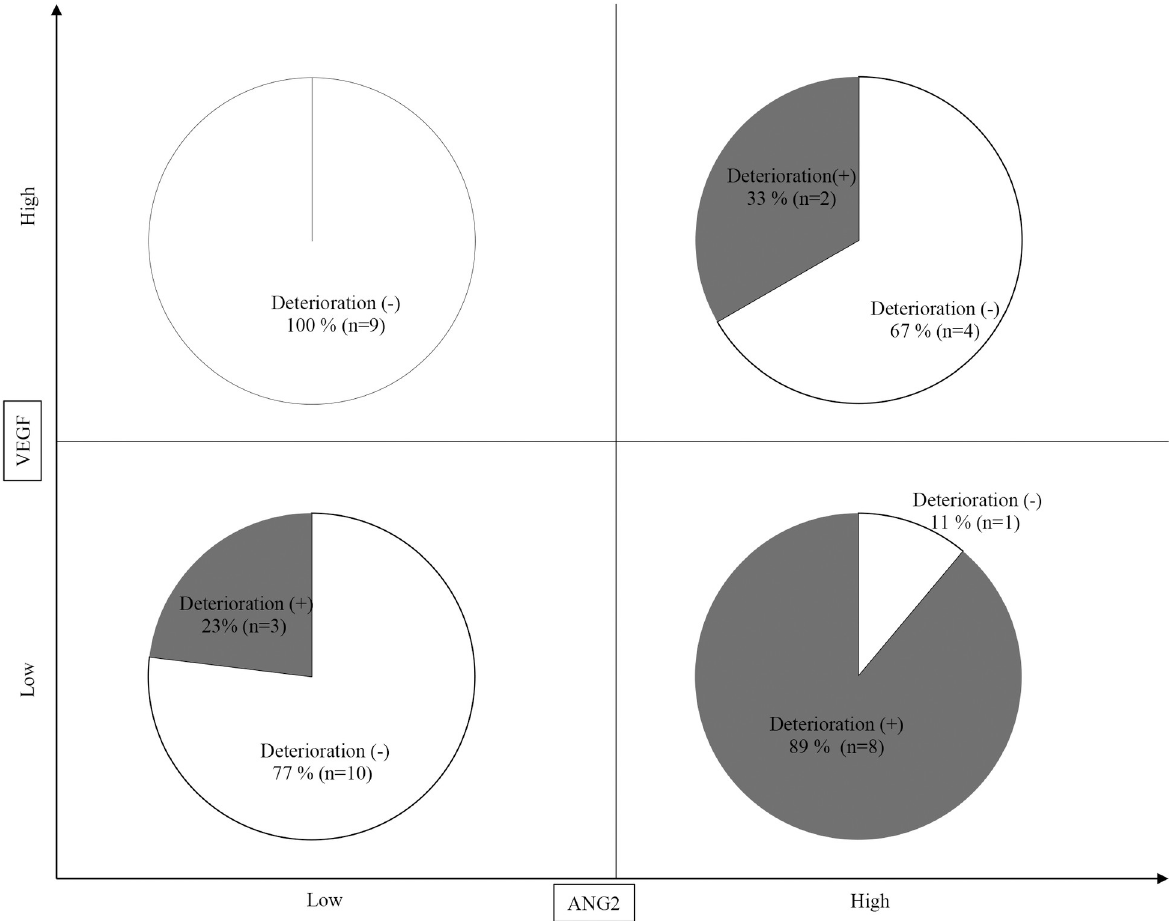
Fig 4. Prediction of deterioration of Child-Pugh score at 8 weeks after lenvatinib initiation based on baseline ANG2 and VEGF levels. Eight out of 9 (89%) patients with baseline low VEGF and high ANG2 levels showed a deterioration of Child-Pugh score at 8 weeks after lenvatinib initiation, whereas none of the patients with high VEGF and low ANG2 levels